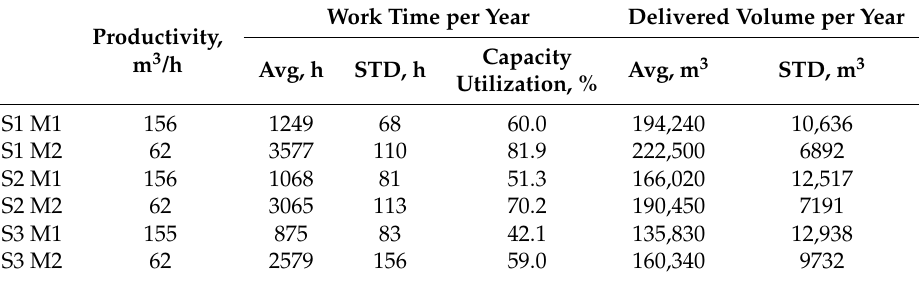
Table 4. Yearly work time and volumes delivered from storage area D to storage area C by machine systems I and II over one year based on 30 simulation runs per scenario. The theoretical yearly full-time working hours for machine systems I and II are 2080 and 4368 h, respectively; the capacity utilization figures in the table are the ratios of their actual numbers of working hours in the simulations to these